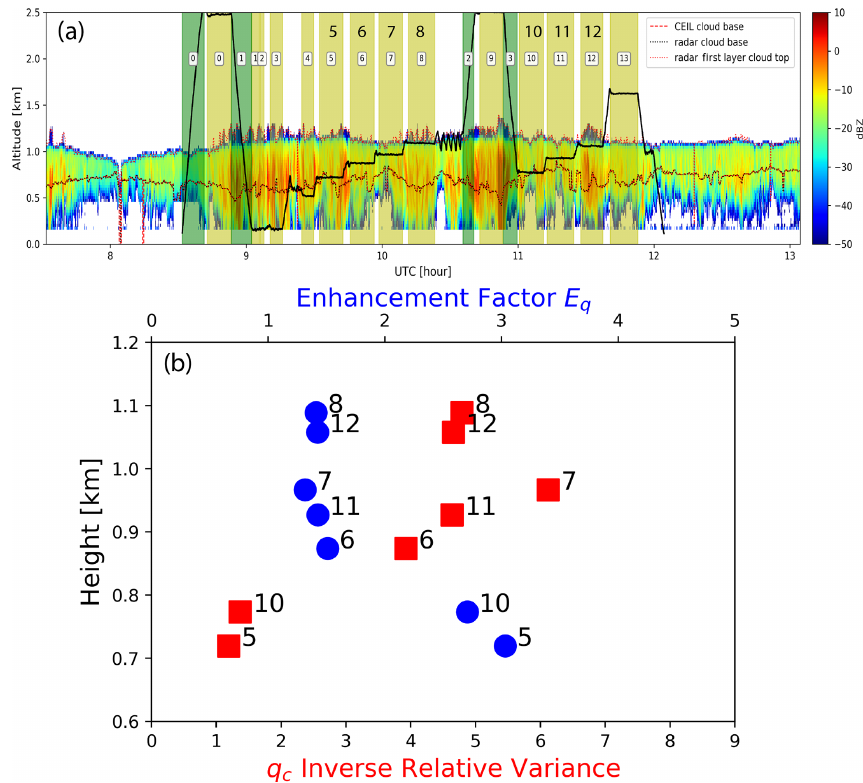
Figure 1. (a) The vertical flight track of the G-1 (thick black line) overlaid on the radar reflectivity contour by the ground-based KAZR during the 18 July 2017 RF around the DOE ENA site on Graciosa Island. The dotted lines in the figure indicate the cloud base and top retrievals from ground-based radar and ceilometer instruments. The yellow-shaded regions are the “hlegs” identified by the Z21 study, among which seven are selected; see the text for their definitions. The figure is adapted from Fig. 1 of Zhang et al. (2021). Panel (b) shows the IRV ν q squares) and enhancement factor E (blue circles) as a function of height that are derived from the selected hlegs 5, 6, 7, 8, 10, 11, and 12 in panel (a) . Note that the lower x axis range differs from that in Fig. 4c of Zhang et al. (2021), as their IRV is calculated as the mean divided by standard deviation (see their caption), whereas we show the mean squared divided by the